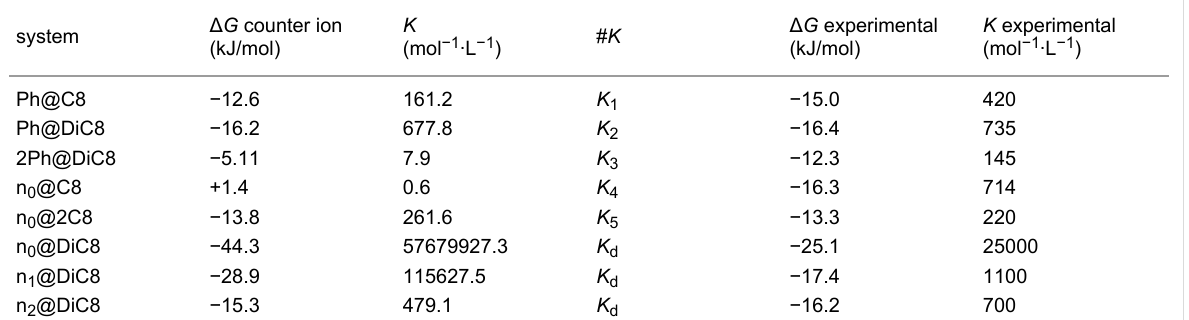
Table 4: Gibbs energy of association Δ G in solution (2.2:1 chloroform/acetonitrile, 298.15 K) and equilibrium constant K for the systems from the double mutant cycle. a